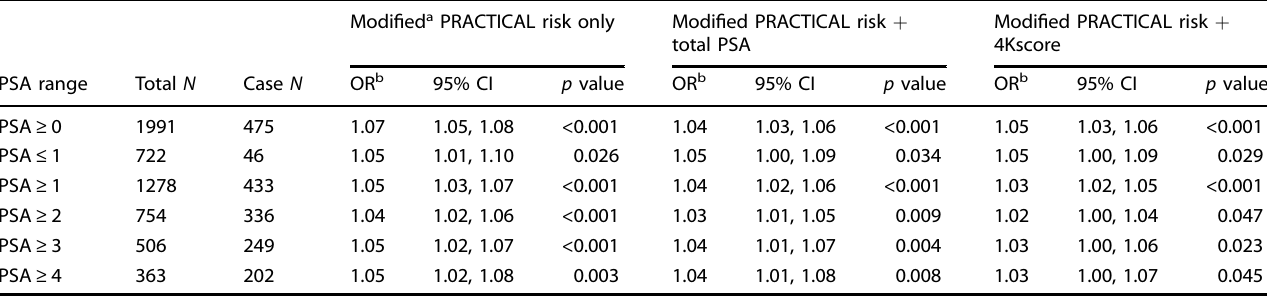
Table 6. Association between modi fi ed PRACTICAL risk score and prostate cancer metastasis or death in both the VIP and MDC cohorts on univariate analysis and adjusted for total PSA and 4kscore among PSA subgroups.